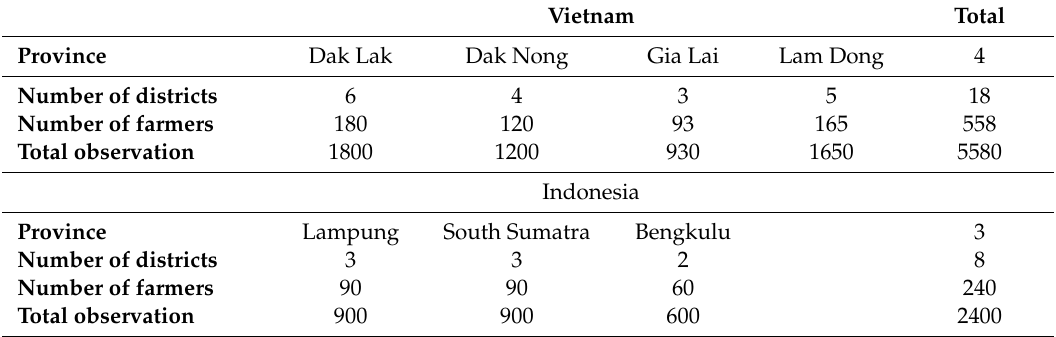
Table 1. Sampling design: numbers of districts and participant farmers in Vietnam and